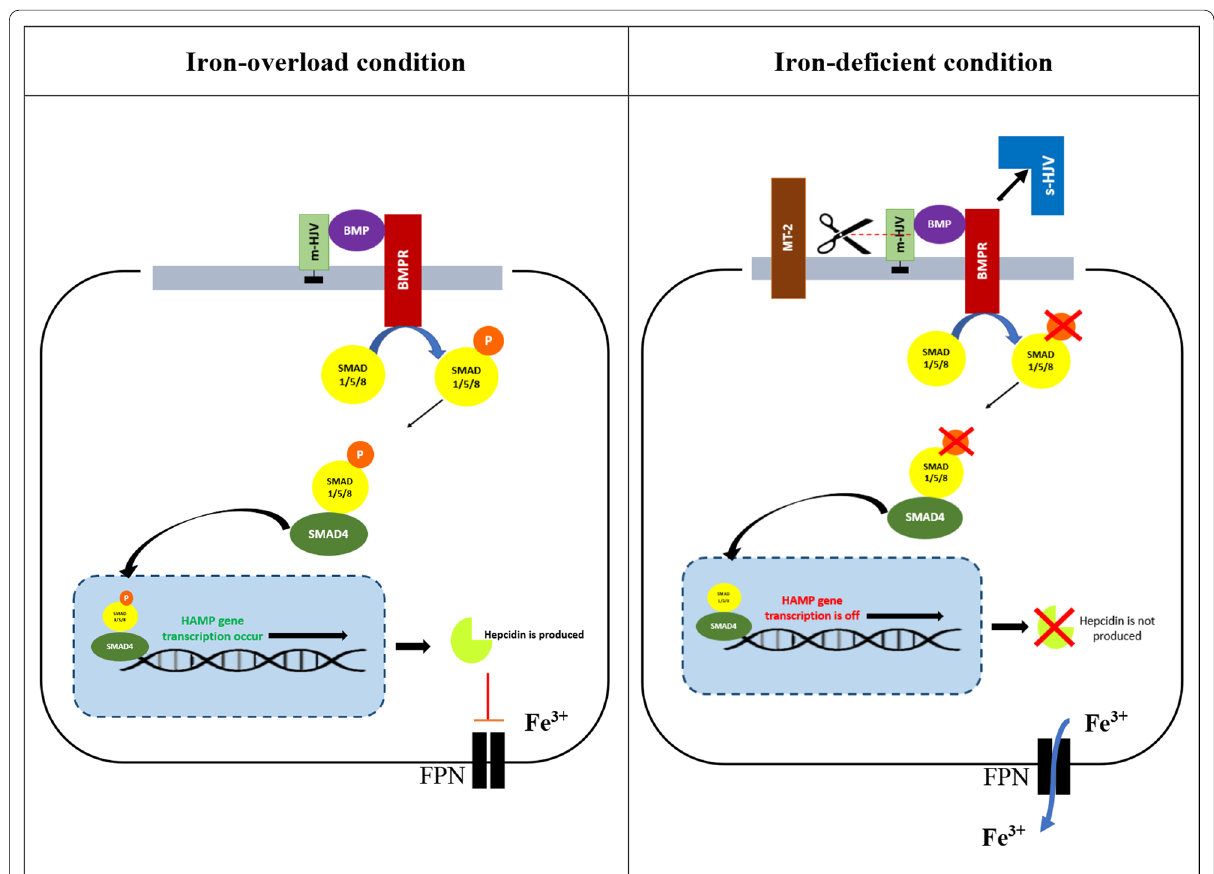
Fig. 3 MT-2 interacts and stimulates the cleavage of hemojuvelin protein on the cell surface resulting in the release of soluble hemojuvelin (s-HJV), thus preventing the phosphorylation of SMAD proteins subsequently inhibits the expression of